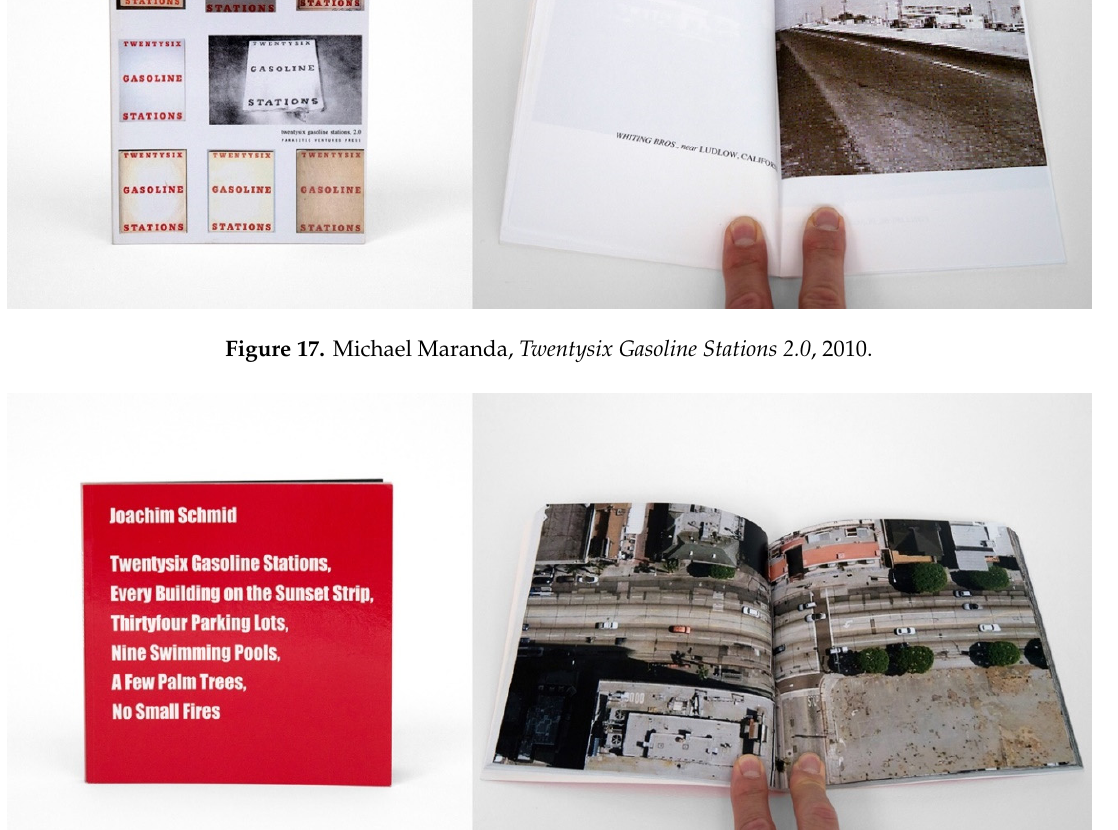
Figure 19. Hermann Zschiegner, Thirtyfour Parking Lots on Google Earth , 2006.